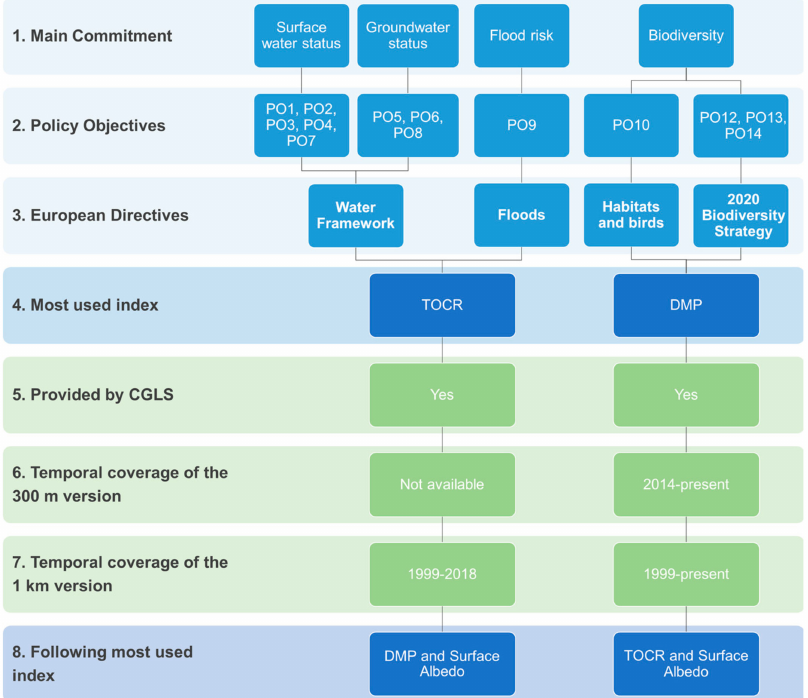
Figure A10. Decision flowchart indicating the most suitable indices available in the Copernicus Global Land Service for the monitoring of the achievement of NWRM-related EU policy